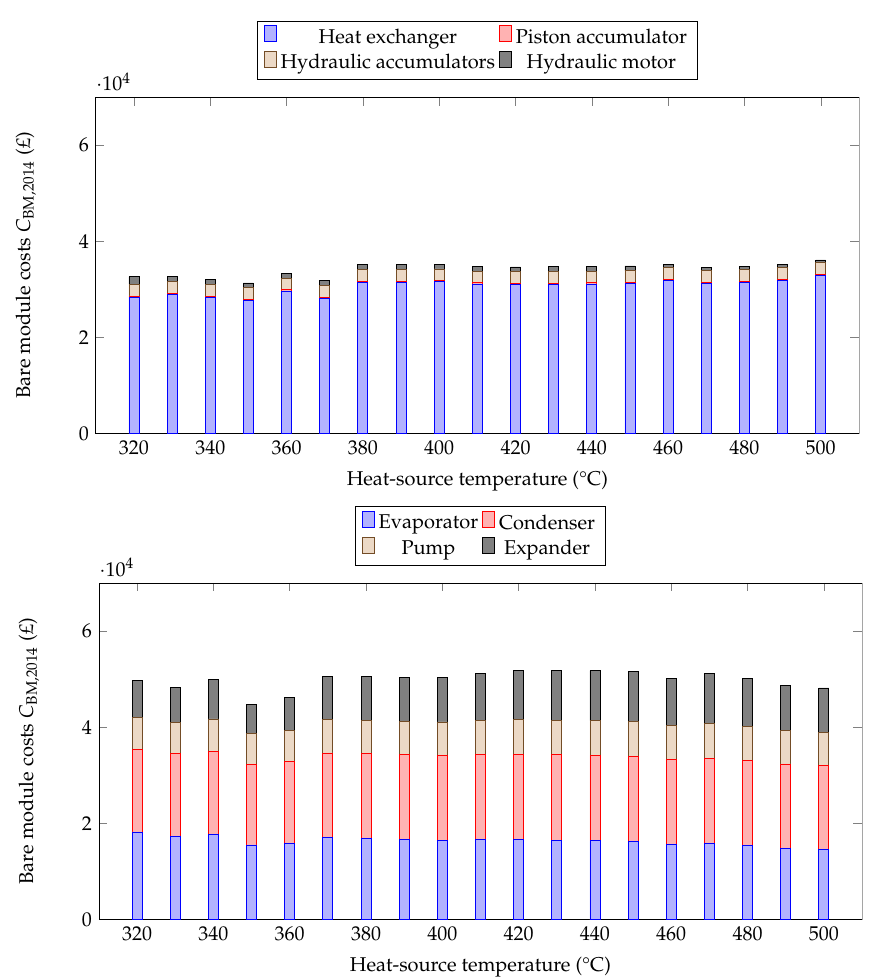
Figure 10. Bare module costs for n -heptane as the working fluid at different heat-source temperatures: ( a ) Up-THERM heat converter; and ( b ) equivalent ORC